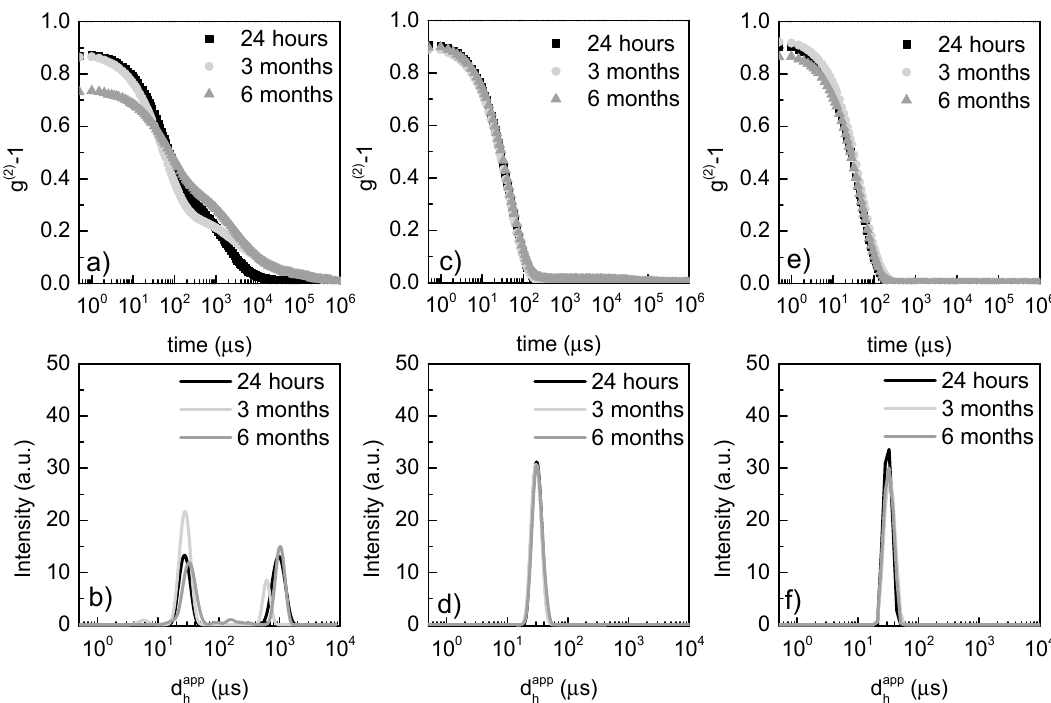
Figure 4. ( a ) Intensity auto-correlation functions for eugenol in water nanoemulsions loaded with tebuconazole (stock dispersion) after different times of storage at 5 °C. ( b ) Intensity-apparent hydrodynamic diameter distributions (obtained from the analysis of intensity auto-correlation functions in panel ( a )) for eugenol in water nanoemulsions loaded with tebuconazole (stock dispersion) after different times of storage at 5 °C. ( c ) Intensity auto-correlation functions for impregnation mixtures with tebuconazole concentration of 0.375 mg/mL obtained upon dilution a stock dispersion after different times of storage at 5 °C. ( d ) Intensity-apparent hydrodynamic diameter distributions (obtained from the analysis of intensity auto-correlation functions in panel ( c )) for impregnation mixtures with tebuconazole concentration of 0.375 mg/mL obtained upon dilution a stock dispersion after different times of storage at 5 °C. ( e ) Intensity auto-correlation functions for impregnation mixtures with tebuconazole concentration of 0.750 mg/mL obtained upon dilution of the stock dispersion after different times of storage at 5 °C. ( f ) Intensity-apparent hydrodynamic diameter distributions (obtained from the analysis of intensity auto-correlation functions in panel ( e )) for impregnation mixtures with tebuconazole concentration of 0.750 mg/mL obtained upon dilution of the stock dispersion after different times of storage at 5 °C.